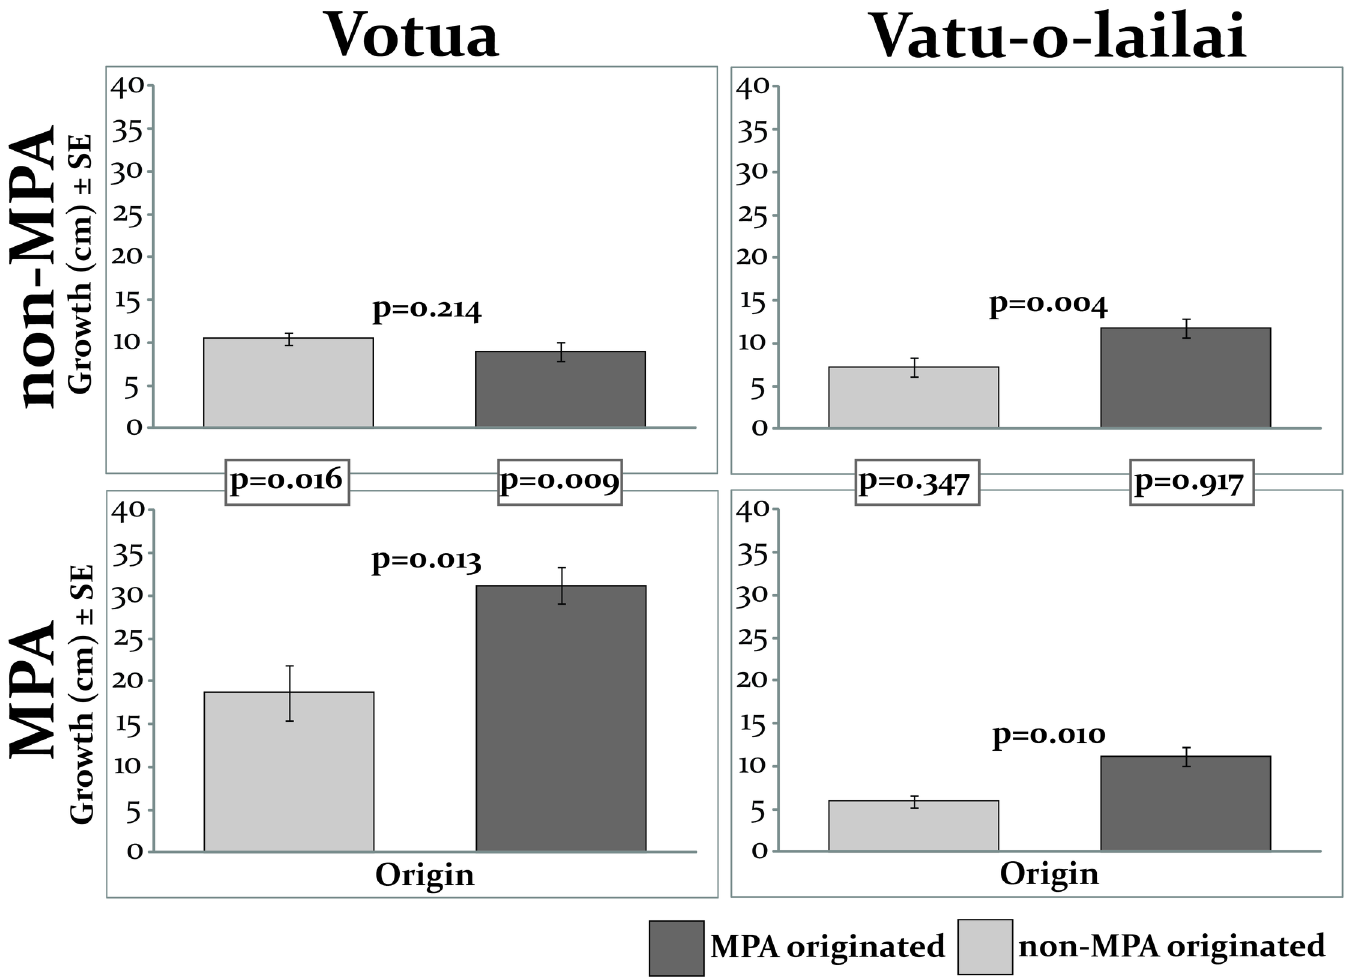
Fig 2. Growth of mature, caged S . polycystum fronds from MPAs and non-MPAs when reciprocally transplanted p-values above the bars are from paired t-tests assessing the effects of origin. The boxed p-values are from Mann-Whitney U tests assessing the effect of habitat (placement within the MPA or non-MPA) on growth. N = 5 at each location; α = 0.025 to correct for multiple contrasts.